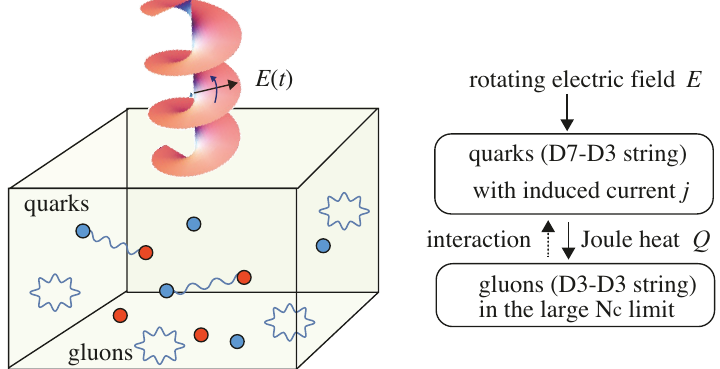
Figure 3. Schematic picture of the energy (cid:13)ow between the degrees of freedom in the system (supersymmetric partners are omitted): the external rotating electric (cid:12)eld couples to the quarks and anti-quarks, and induces a current. The gluons mediates a long-range interaction between the quarks while they act as a heat bath stabilizing the